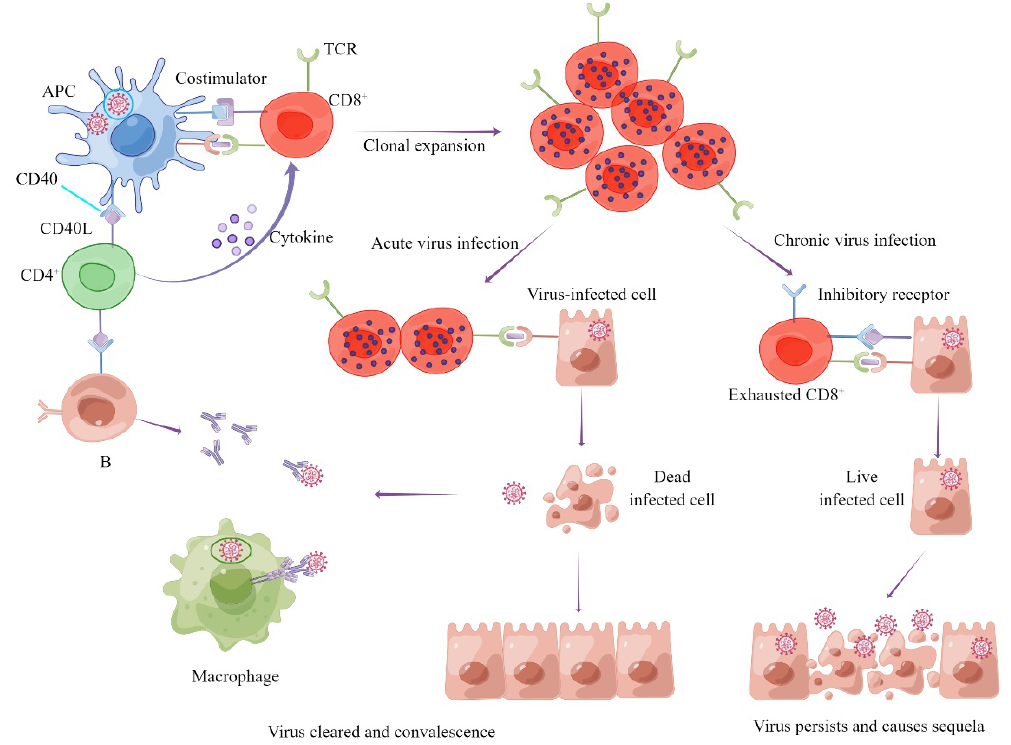
Figure 2. The underlying mechanisms of clearing SARS-CoV-2 or virus latency and causing seque-